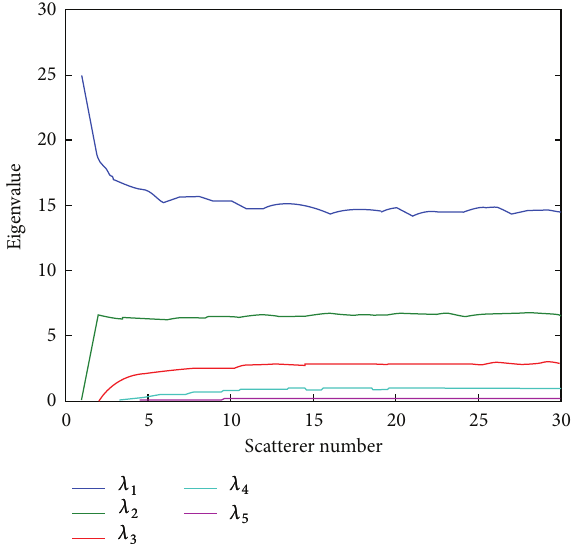
F 5: Eigenvalues comparison in NLOS.